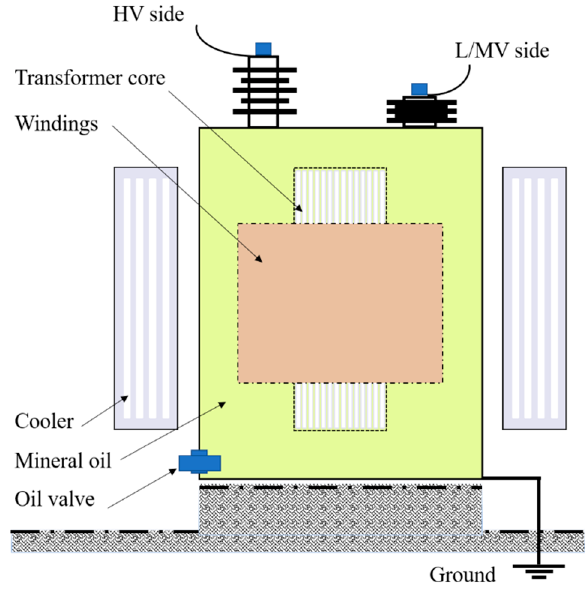
Figure 1. Oil-immersed power transformer cross-section.